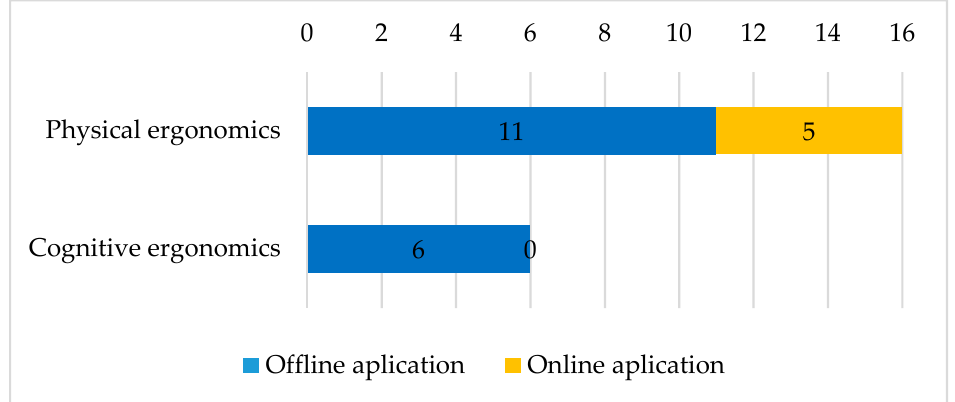
Figure 5. Articles distribution per type of ergonomics (physical or cognitive) related to its ergonomic application (offline or online).